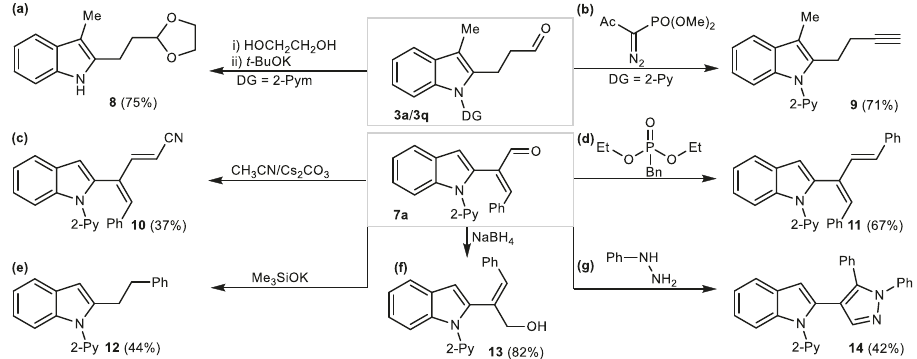
Fig. 5 | Synthetic applications. a Removal of pyrimidyl group. b Alkynylayion of aldehydes. c Cyanation ofaldehydes. d Arylvinylation of aldehydes. e Reduction of carbon – carbon double bonds and carbonyl group from α , β -unsaturated